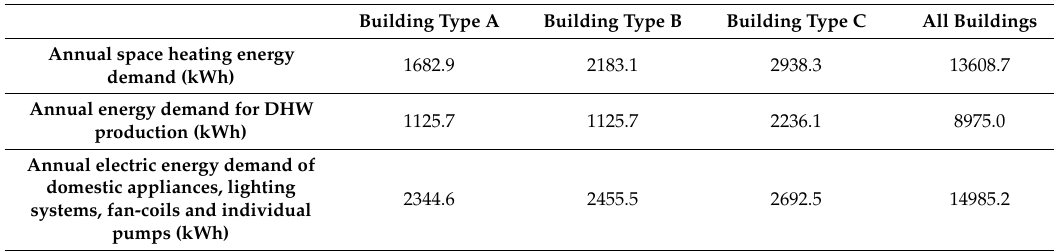
Table 2. Annual energy demands of the